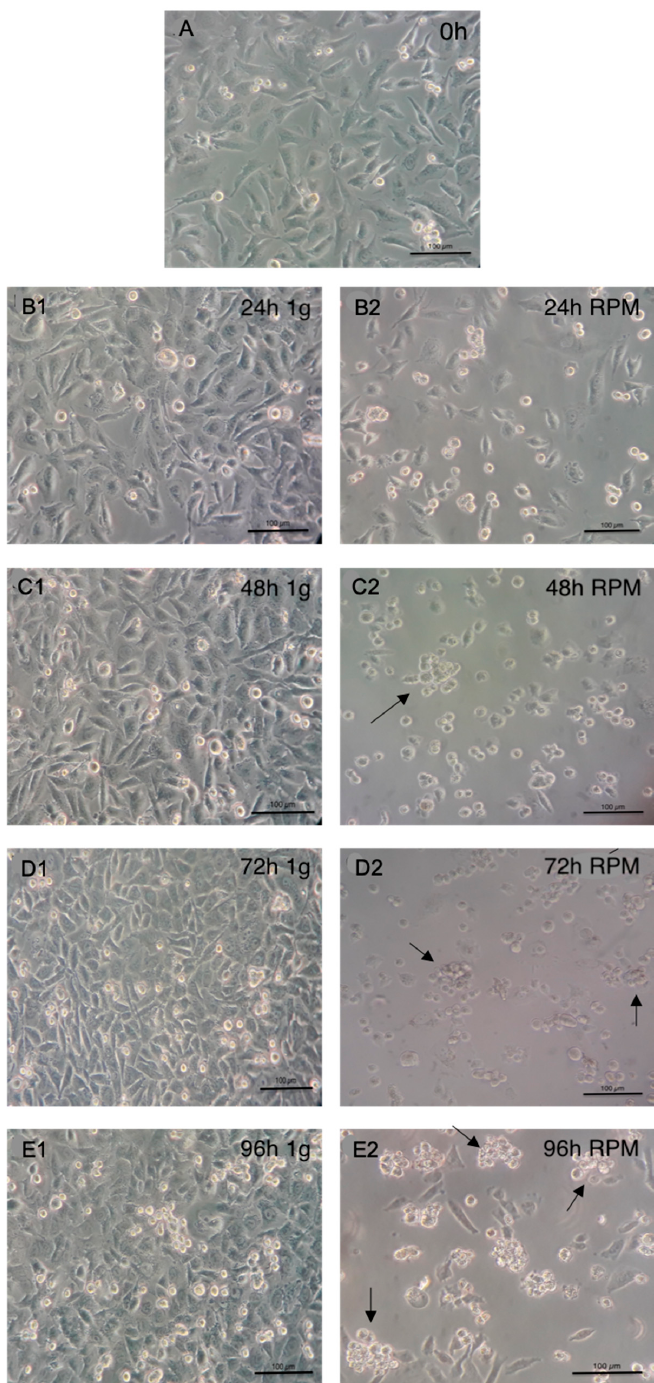
Figure 1. Light microscopy 100x magnification. ( A ) At starting timepoint, ( B ) at 24 h, ( C ) at 48 h, ( D ) at 72 h and ( E ) at 96 h. Control images, left; cells under simulated microgravity, right. Arrows indicate spheroids.